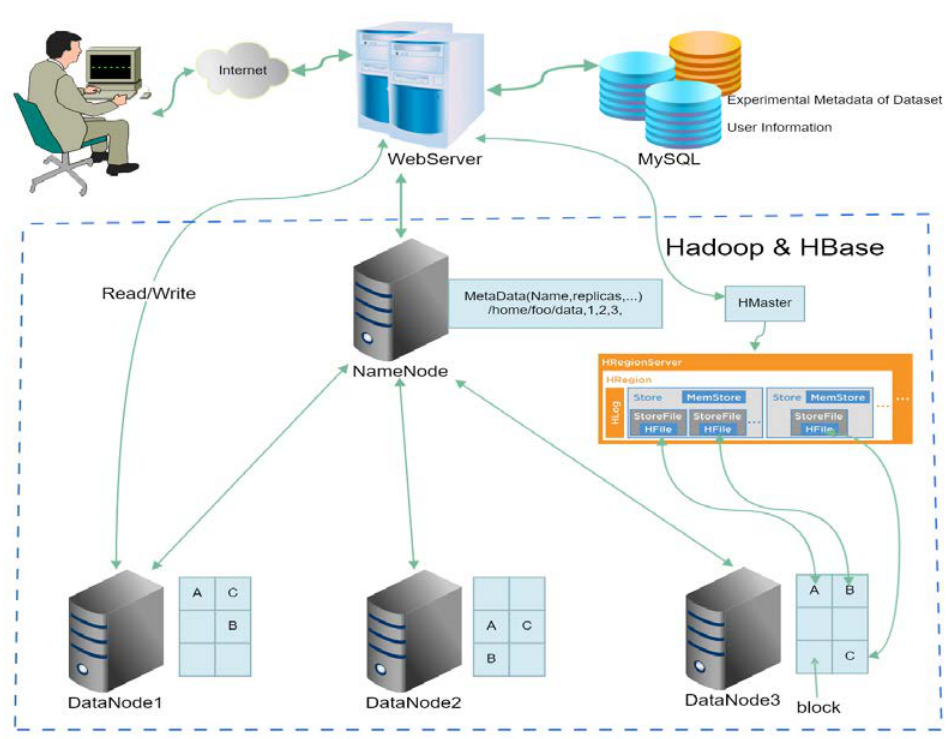
Figure 3. Data storage process of MySQL, HDFS and HBase. MySQL stores the user information and metadata, HDFS stores MEA files, HBase stores small files.